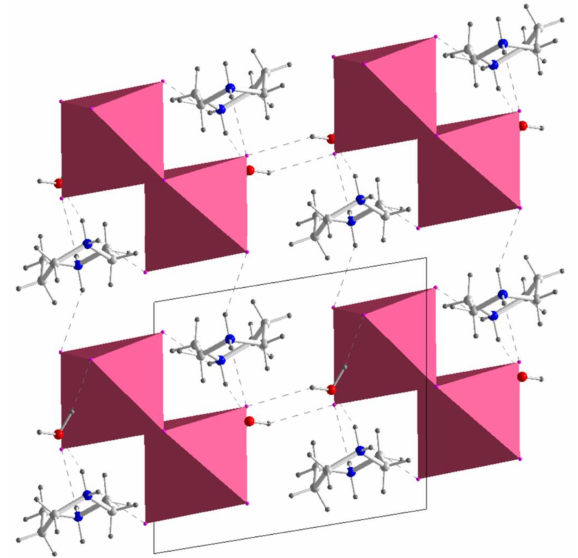
Figure 2. View of the crystal structure of (HpipeH 2 ) 2 Bi 2 I 10 · 2H 2 O along the c axis. Bi 2 I 10 4– octahedra, magenta; oxygen, red; nitrogen, blue; carbon, light gray; hydrogen, dark gray. Hydrogen (N)H ··· O, (O)H ··· I, and (N)H ··· I bonds are shown as dashed lines; the unit cell is depicted by thin black